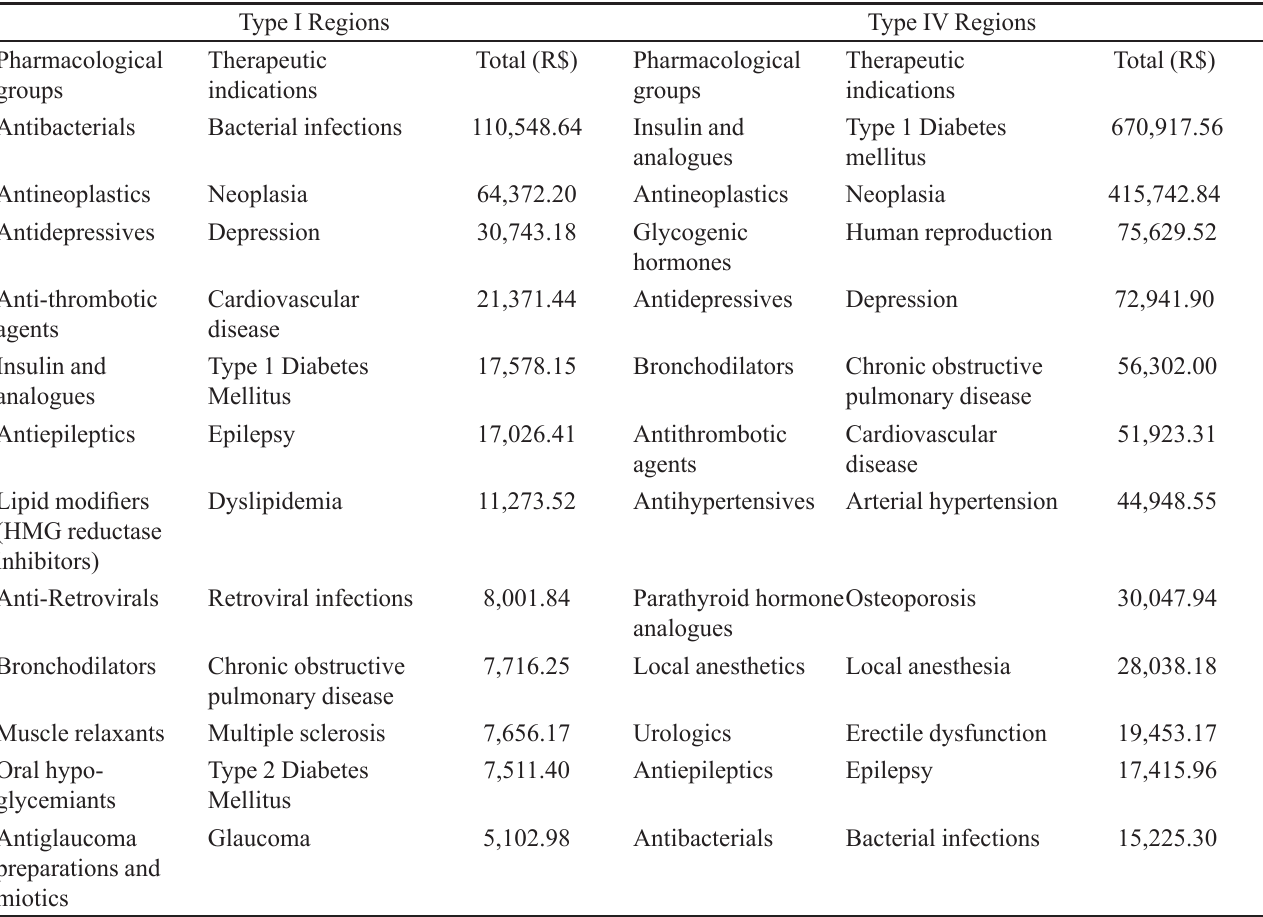
TABLE II - Pharmacological groups and their respective therapeutic indications of group A from the ABC Curve drugs, in decreasing order of financial importance in Type I and IV Regions - Goiânia, Goiás.